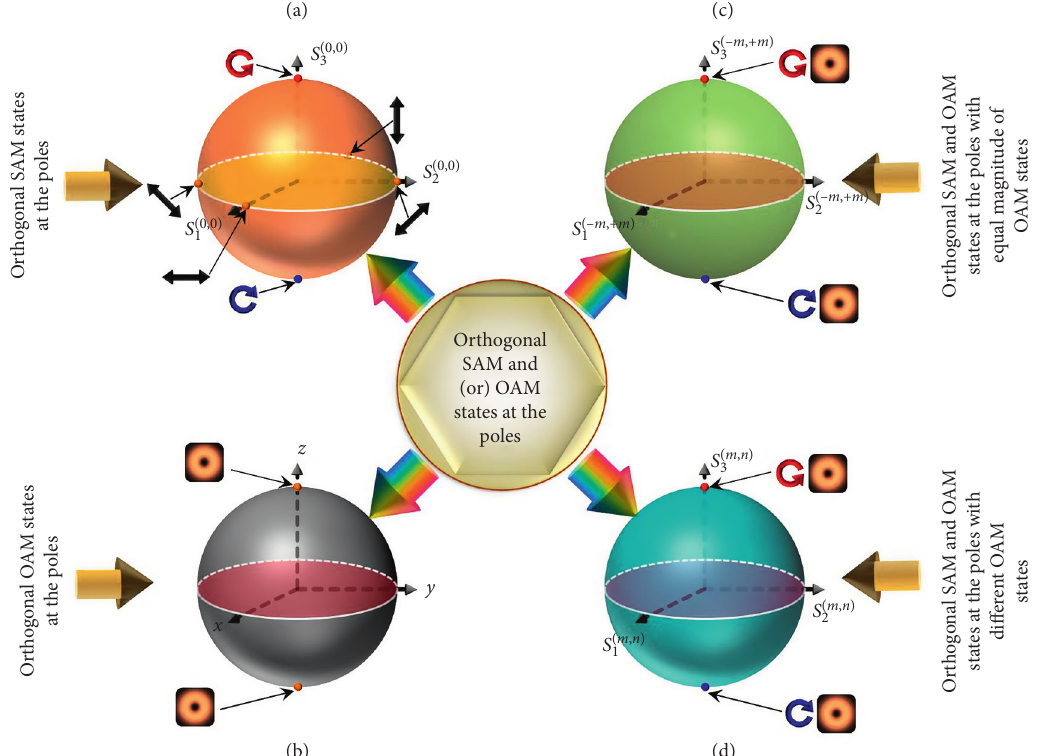
Figure 12: Construction of various spheres. (a) Fundamental Poincar´e sphere: orthogonal spin angular momentum (SAM) states at the poles. (b) Modal sphere: orthogonal orbital angular momentum (OAM) states at the poles. (c) Higher order Poincar´e sphere: orthogonal SAM and OAM states at the poles with equal magnitude of OAM states. (d) Hybrid order Poincar´e sphere: orthogonal SAM and OAM states at the poles with different OAM states. Note that in each sphere, the eigenstates are